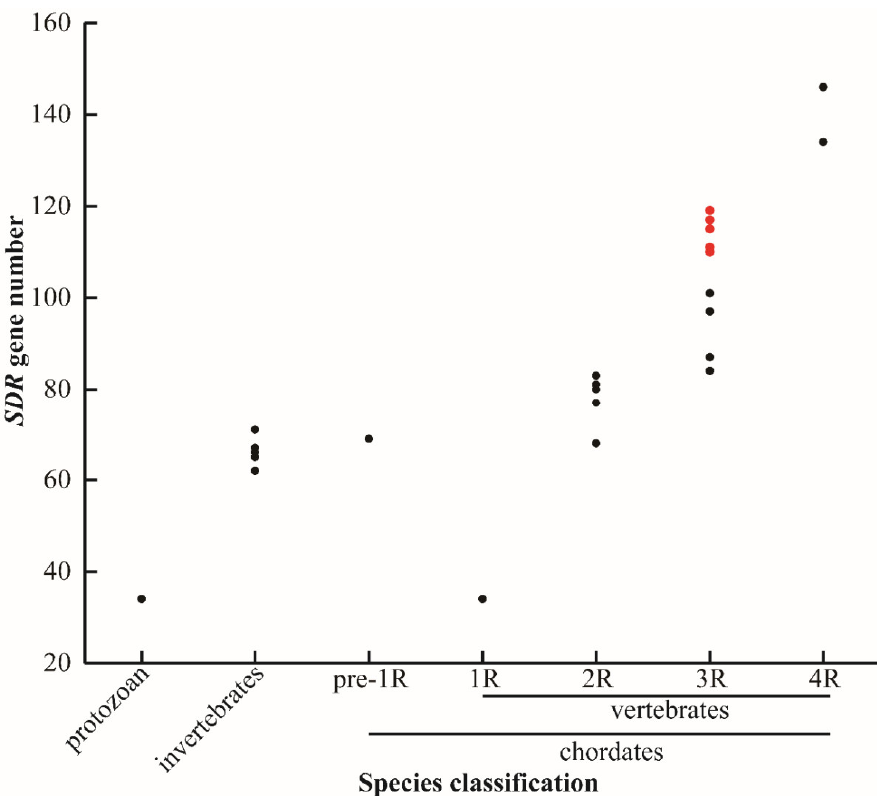
Figure 1. SDR gene numbers in different species. Protozoan represents unicellular animals: para- mecium (34). Invertebrates: fruit fly (62), domestic silkworm (65), nematode (66), sponge (67), and black tiger shrimp (71). Pre-1R species: vase tunicate (69). 1R species: lamprey (34). 2R species: elephant shark (68), human (77), spotted gar (80), coelacanth (80), tropical clawed frog (81), chicken (83), and python (83). 3R species: channel catfish (84), zebrafish (87), medaka (97), fugu (97), large yellow croaker (101), zebra mbuna (114), Flier cichlid (111), Eastern happy (117), blue tilapia (110), Mozambique tilapia (114), blackchin tilapia (115), and Nile tilapia (119). 4R species: common carp (134) and rainbow trout (146). Red dots represent seven cichlids. 1R, 2R, 3R, and 4R represent four rounds of whole genome duplication (WGD). The identified SDR s in lamprey is extraordinarily low, probably due to poor genome assembly.